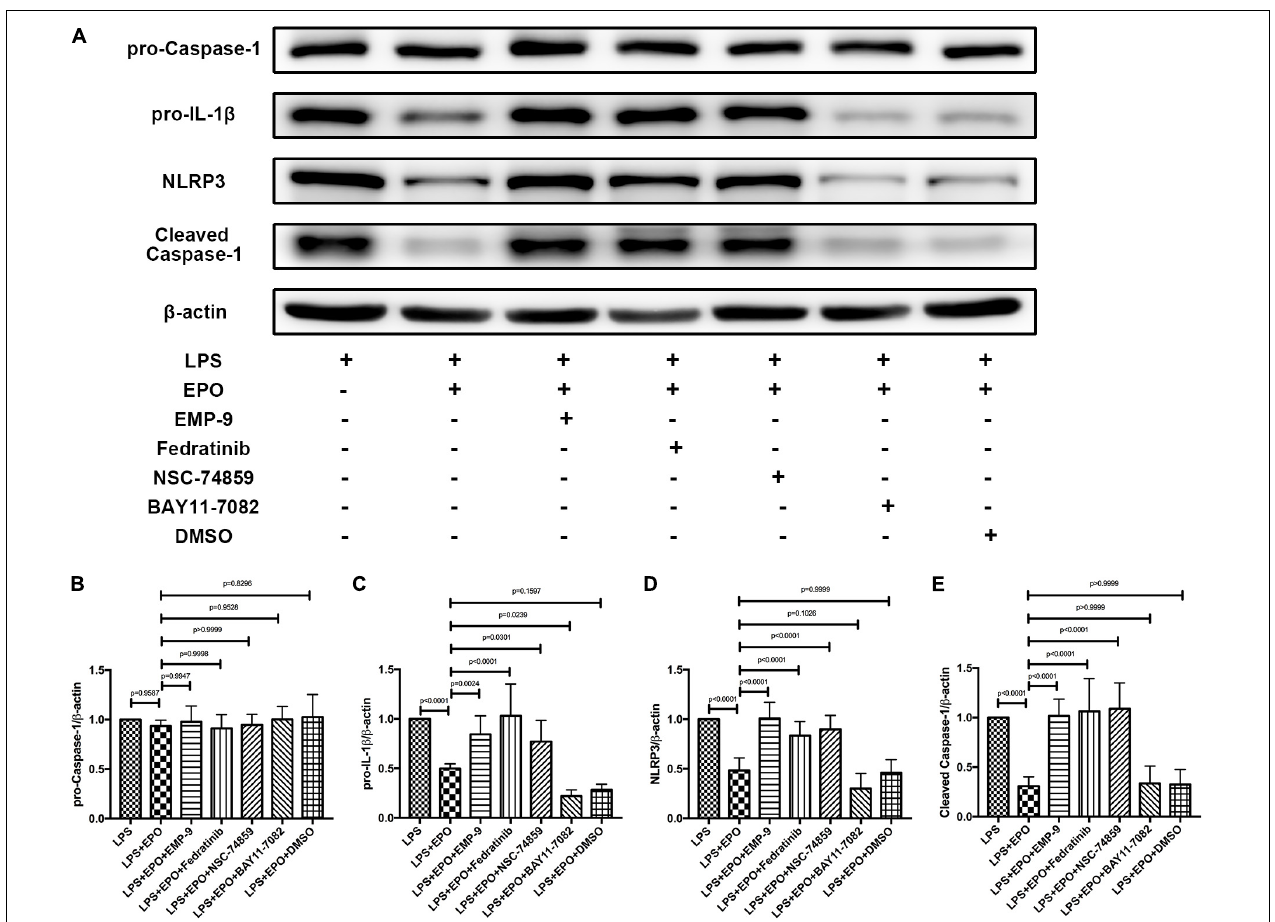
FIGURE 6 | Inhibitors of the EPOR/JAK2/STAT3 pathway reversed the suppressing effect of EPO on the NLRP3 inflammasome. EMP9 (an EPOR antagonist, 1 mg/mouse), Fedratinib (a JAK2 inhibitor, 100 mg/kg), NSC 74859 (a STAT3 inhibitor, 5 mg/kg), BAY 11-7082 (an NF- κ B inhibitor, 20 mg/kg), and DMSO (solvent of the inhibitors) were injected into the peritoneal cavity 30 min before EPO treatment. Then, EPO (5 U/g) was injected into the peritoneal cavity of mice after LPS (15 mg/kg) stimulation. The mice were sacrificed 8 h later, and the lung tissues were harvested to measure the protein expression levels of pro-caspase-1, pro-IL-1 β , NLRP3, cleaved caspase-1 (A–E) by Western blotting. The data are presented as the mean ± SD. The differences among groups were assessed by one-way ANOVA and the post hoc test (Turkey method) was applied to investigate the differences one by one. n = 8 per